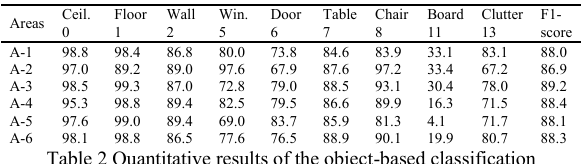
Table 2 Quantitative results of the object-based classification